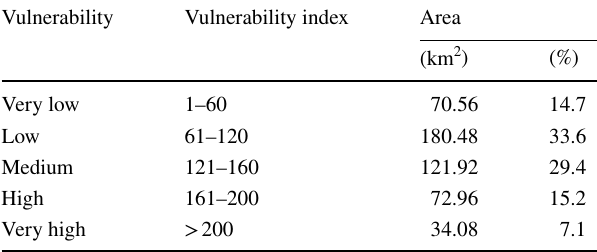
Table 1 Evaluation criteria of degree of vulnerability in DRASTIC